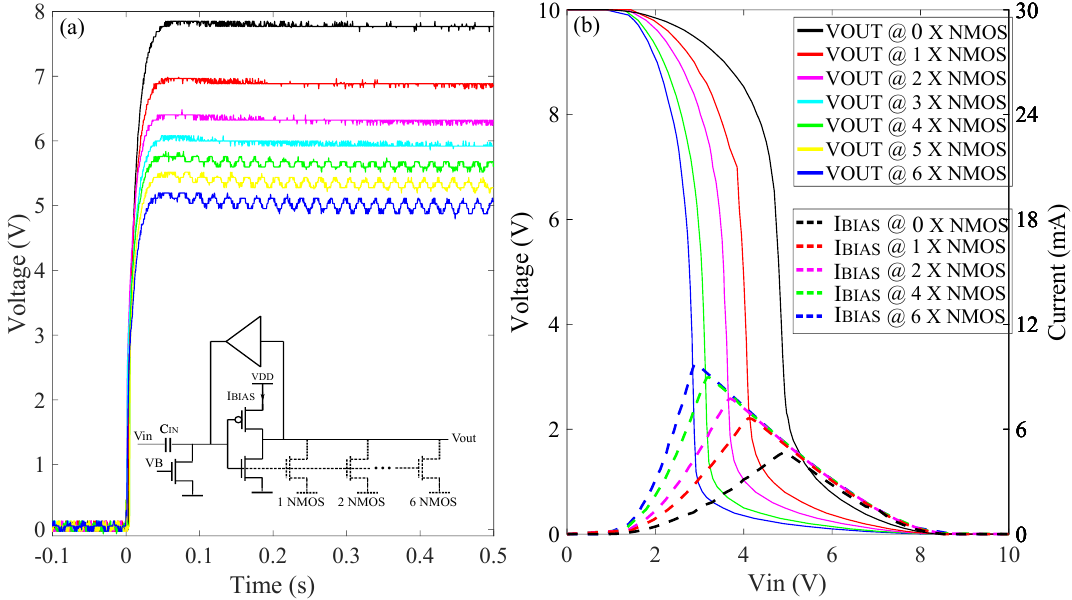
Figure 21. Initial transient and static analysis after the implementation of the offset compensation technique based on the increasing strength of the N -branch of the inverter. ( a ) Initial transient analysis. ( b ) Static analysis. V B = 0.535 V.